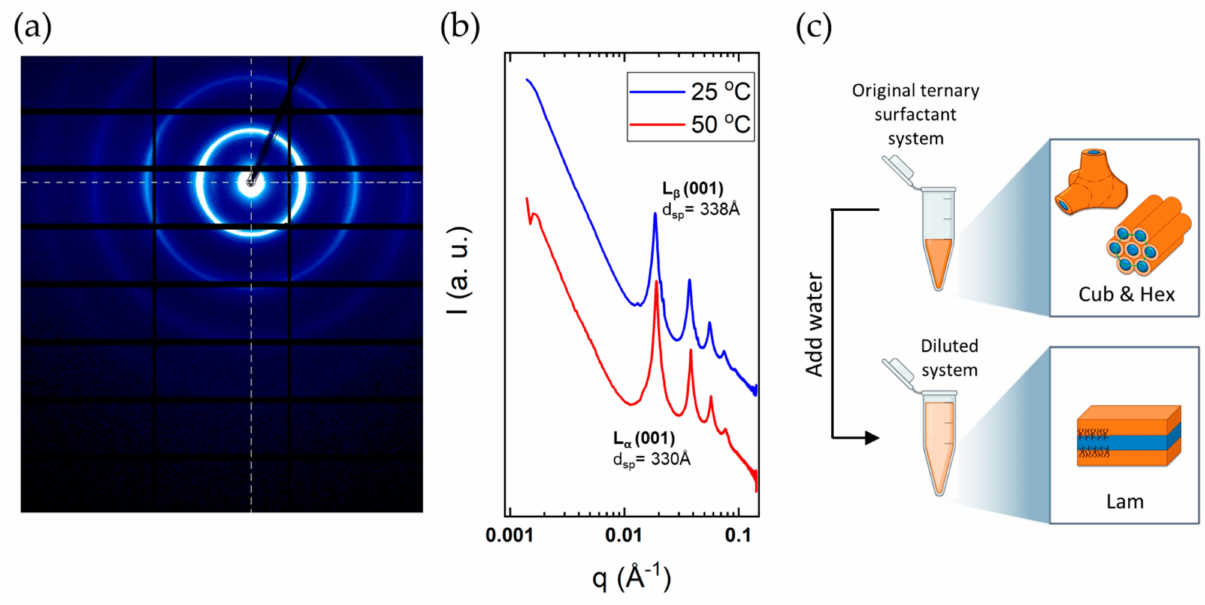
Figure 14. SAXS analysis of diluted (10 times) 35 wt% DODAC-12.5 wt% Octanol in water. ( a ) 2D scattering pattern at 50 ◦ C and ( b ) corresponding 1D integrated pattern at 25 ◦ C and 50 ◦ C. ( c ) Scheme of the phase evolution on dilution with